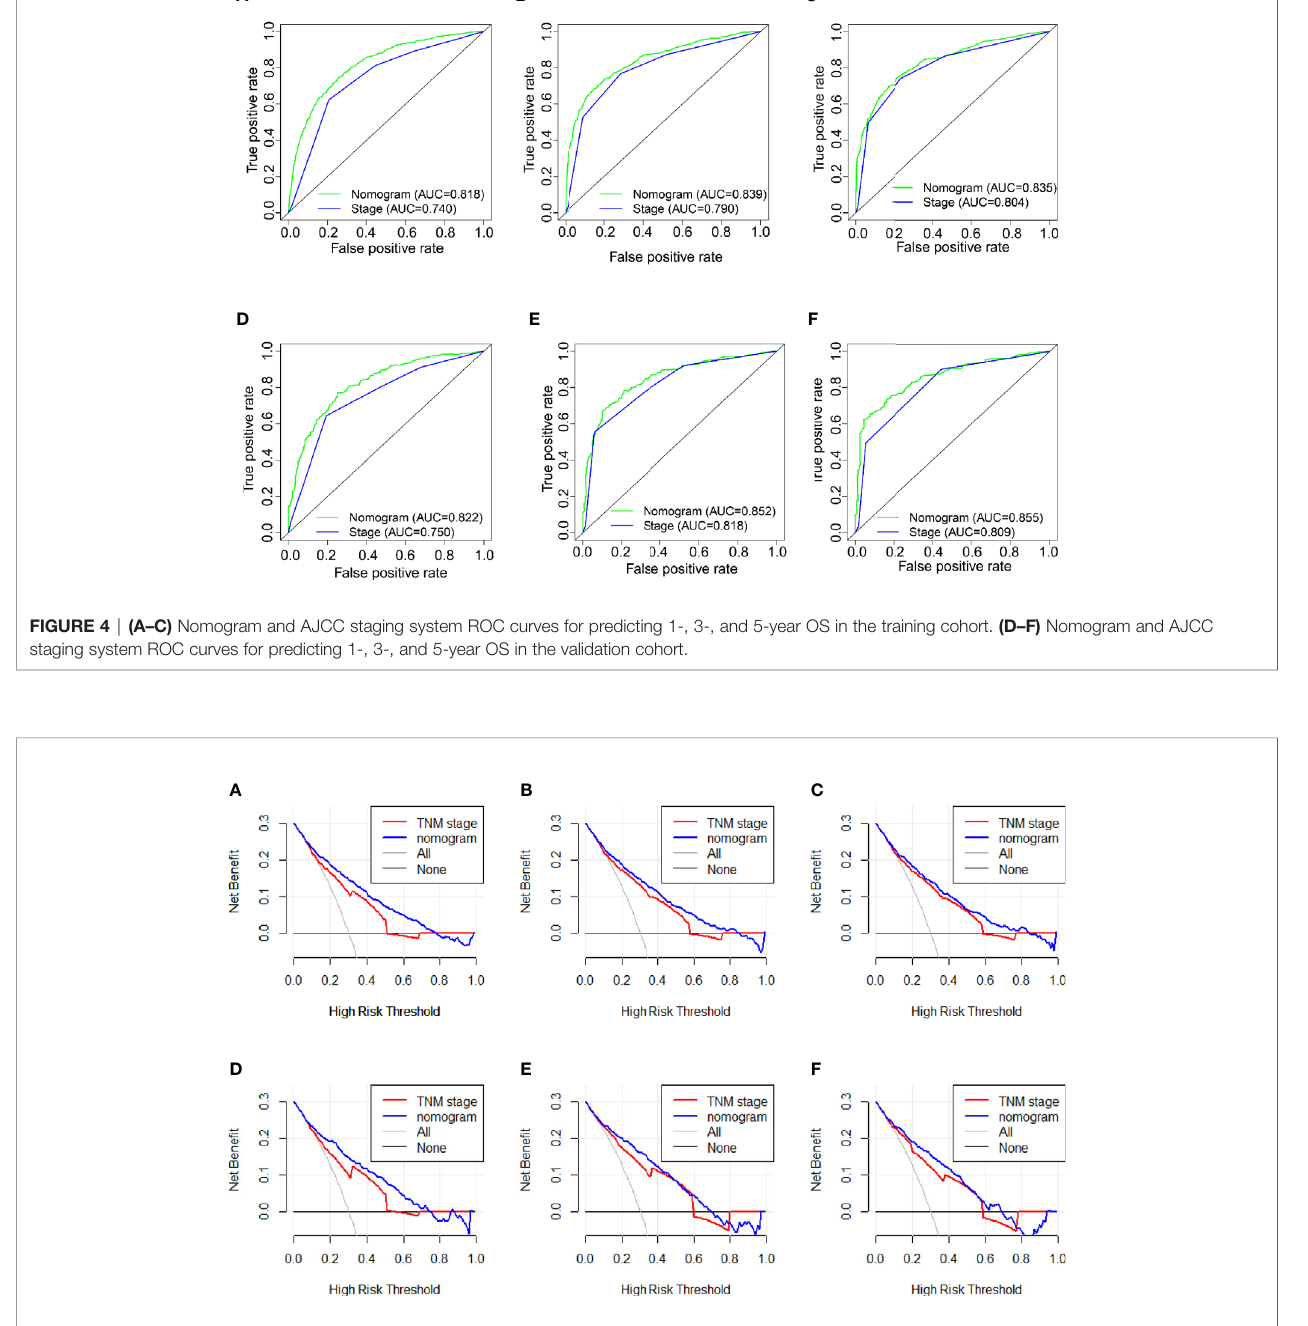
FIGURE 5 | (A – C) Nomogram and AJCC staging system DCA analysis predicting 1-, 3-, and 5-year OS in the training cohort. (D – F) Nomogram and AJCC staging system DCA analysis predicting 1-, 3-, and 5-year OS in the validation